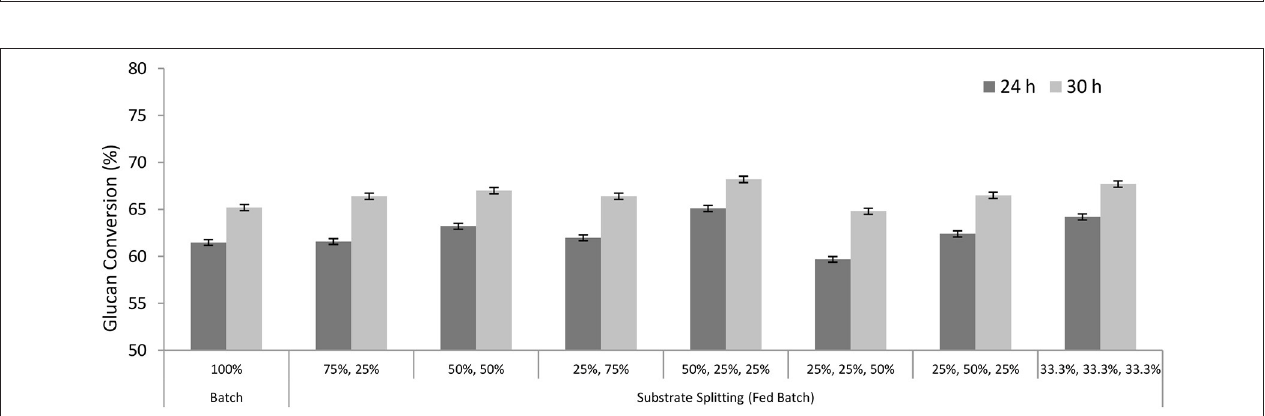
FIGURE 5 | Glucan conversion during substrate splitting in fed-batch experiments. Time of substrates addition was constant (0, 4, and 8h) and whole enzyme (100%) was added at the beginning.